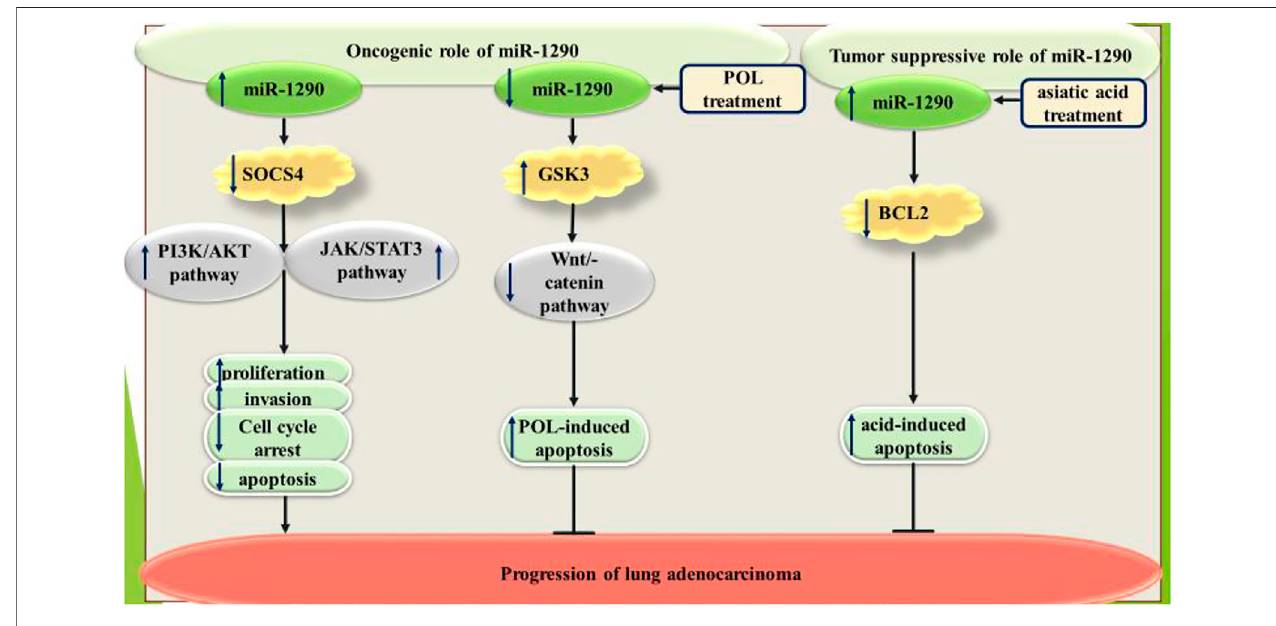
FIGURE 1 | Dual roles of miR-1290 in the pathoetiology of lung cancer.